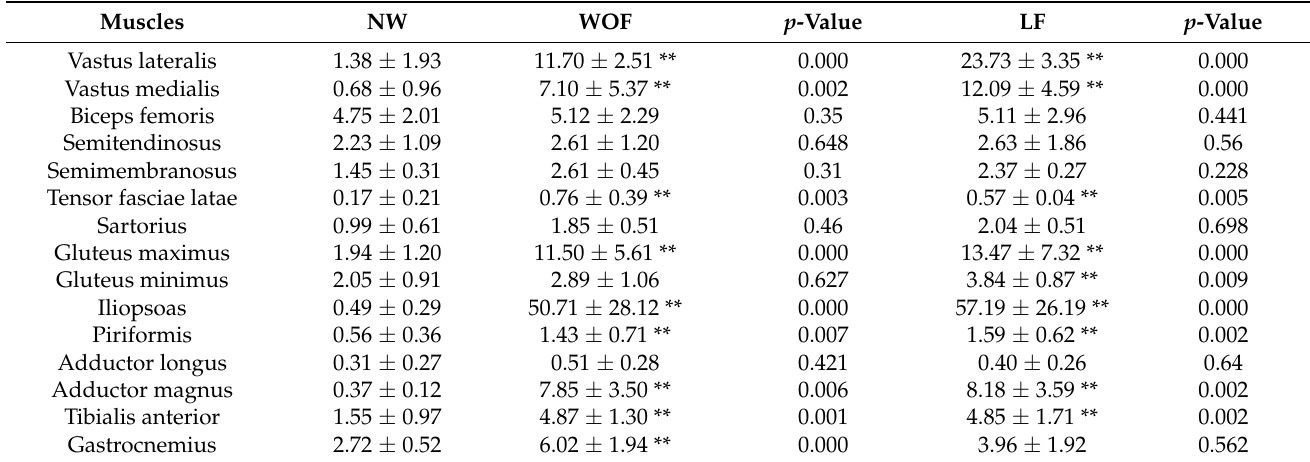
Table 4. Mean and standard deviation (mean ± SD) of muscle strength during WOF, LF, and NW. Units: N/BW.